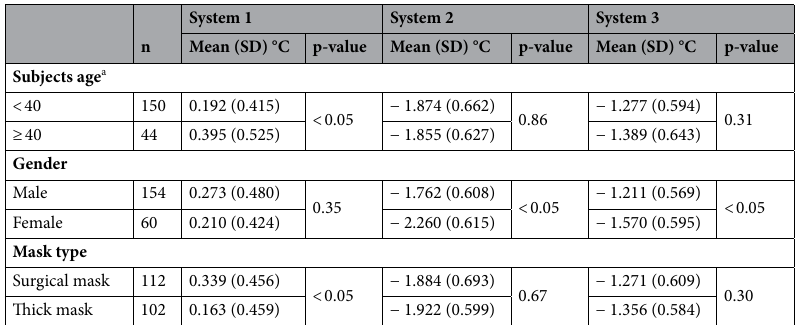
Table 4. Results of examining the error of each IRT system in relation to each of the recorded characteristics. Factors which have a p-value of < 0.05 are shaded. N = 214. a Subjects were given the option to not give an age, so 20 measurements were not included in the age